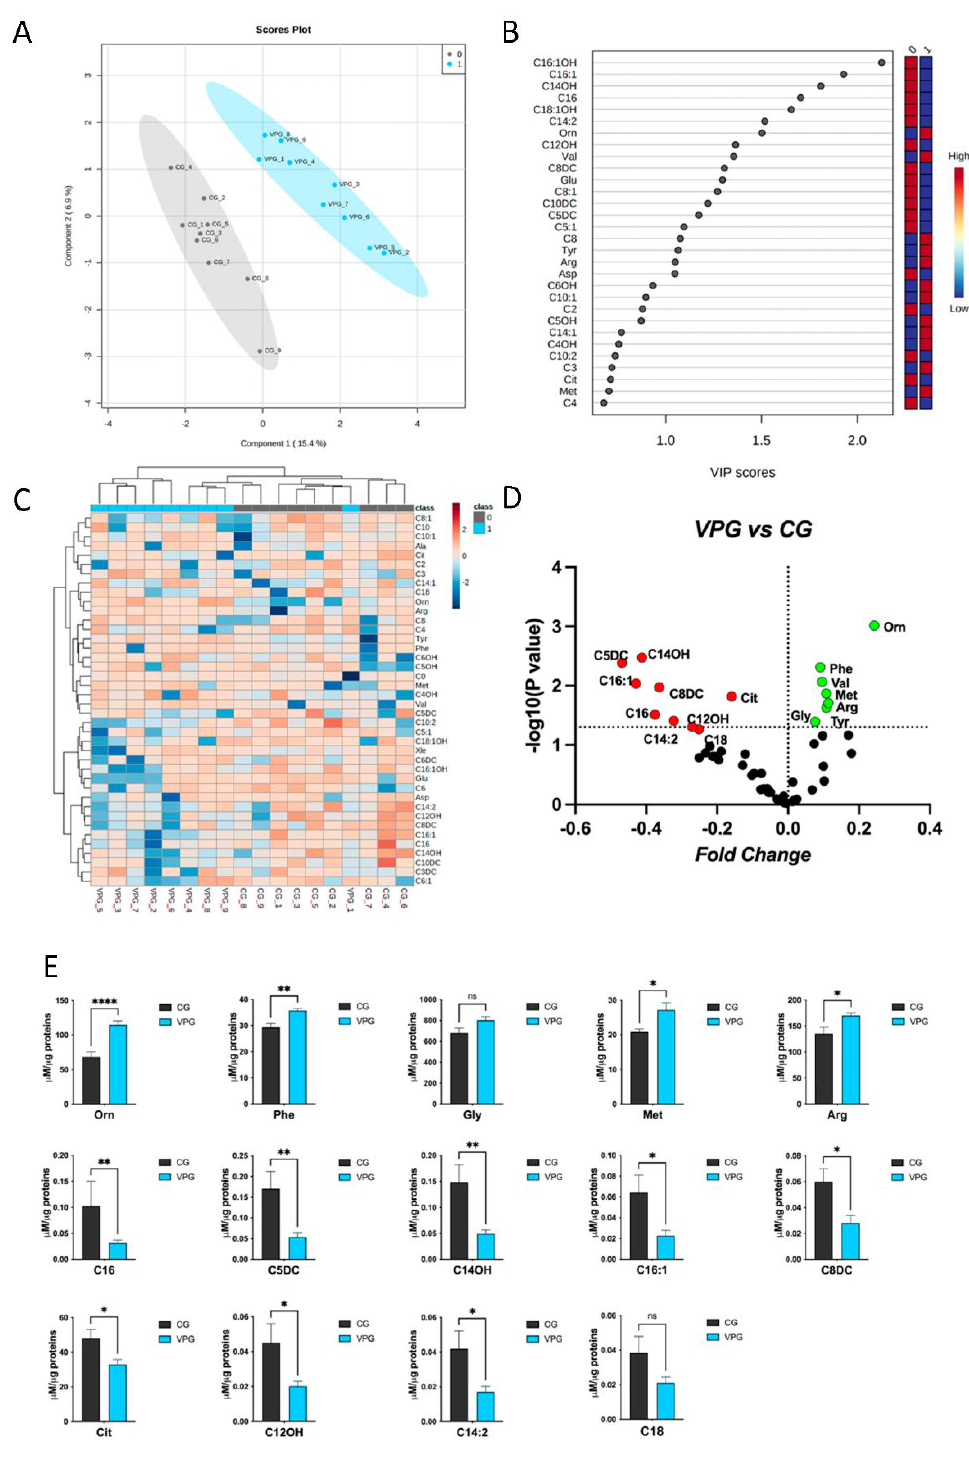
Figure 3. Metabolomic discriminant analysis of the VPG. ( A ) A supervised partial least squares- discriminant analysis (PLS-DA) was performed using the metabolome dataset. Muscle